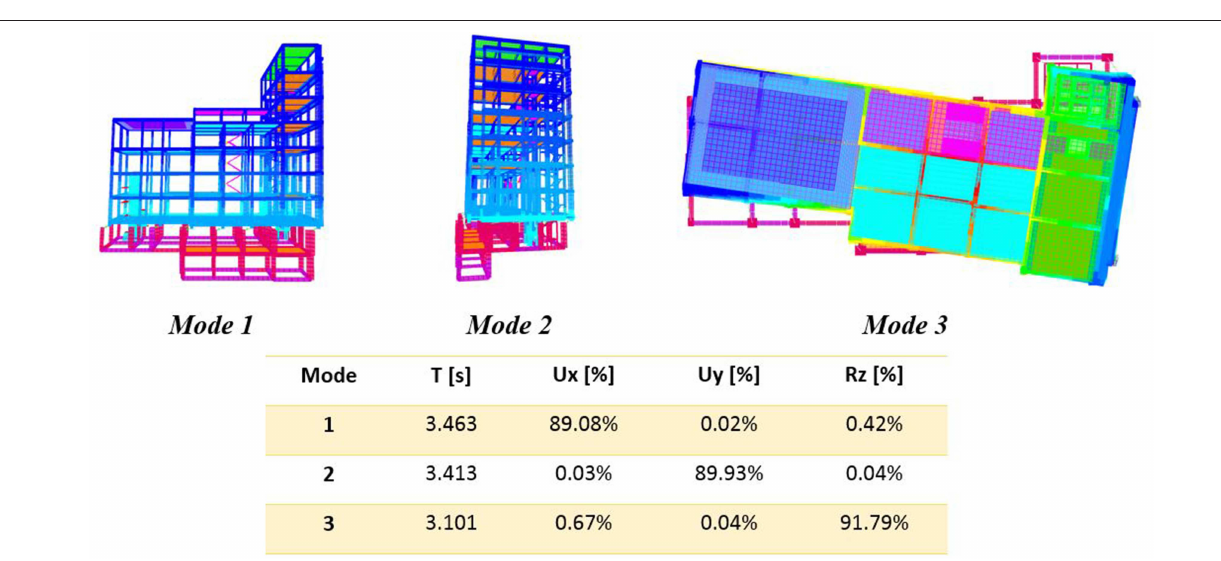
retrofit (i.e., when a gC / a gD = 100%), 19 interventions on columns are needed. More in detail, 12 columns need of interventions to improve shear resistance and 7 columns need